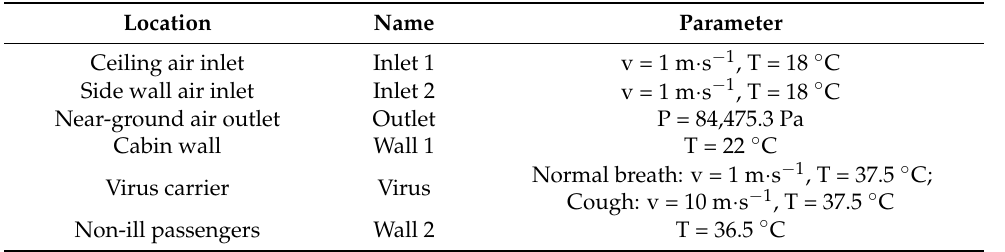
Table 2. Boundary condition